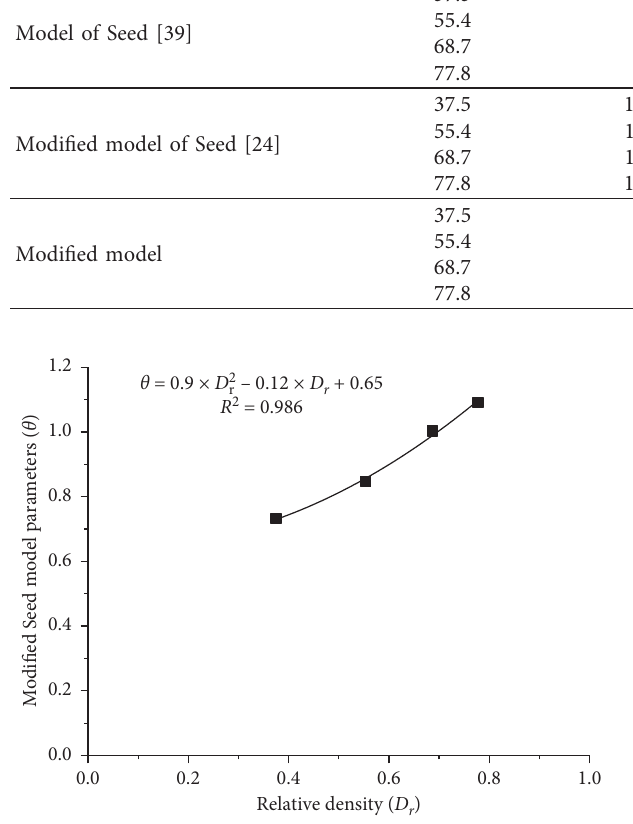
Figure 16: Relationship between D